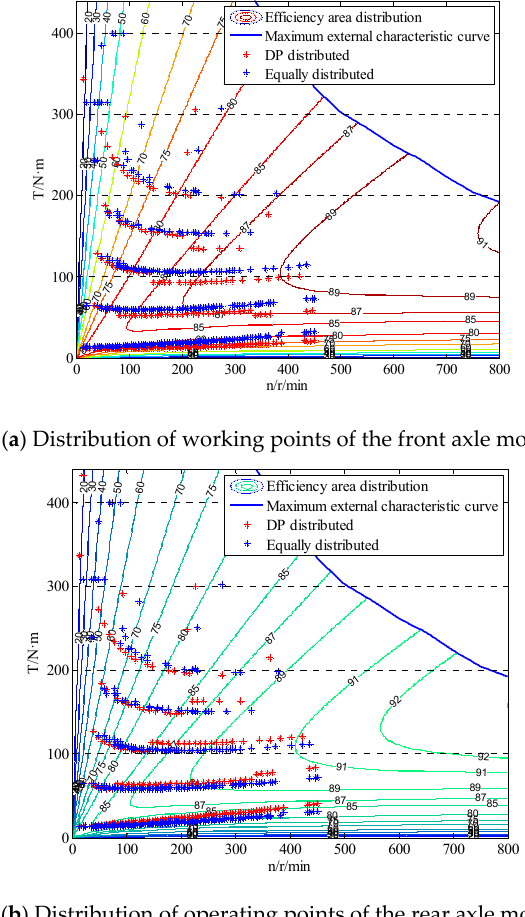
Figure 14. Distribution of motor operating points for different torque distribution strategies of HUPDC.